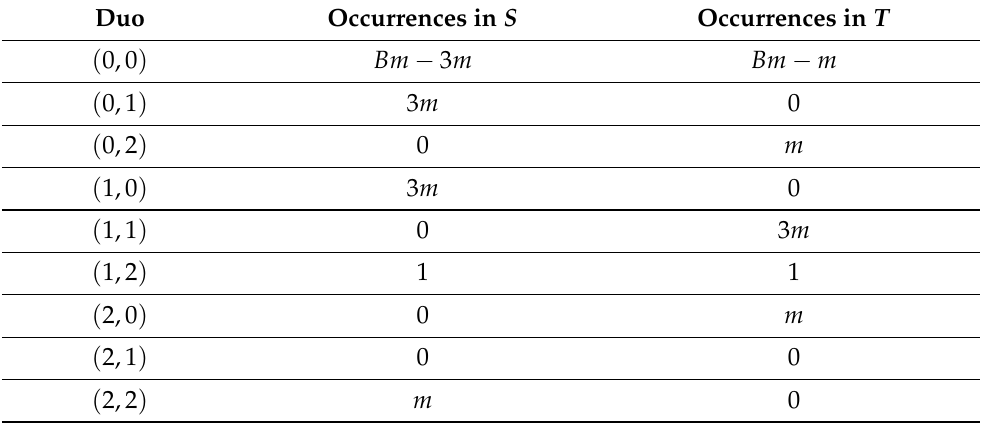
Table 2. Exhaustive list of duos present both in S and T , together with their occurrences. Duo Occurrences in S Occurrences in T ( 0, 0 ) Bm 3 m Bm − −